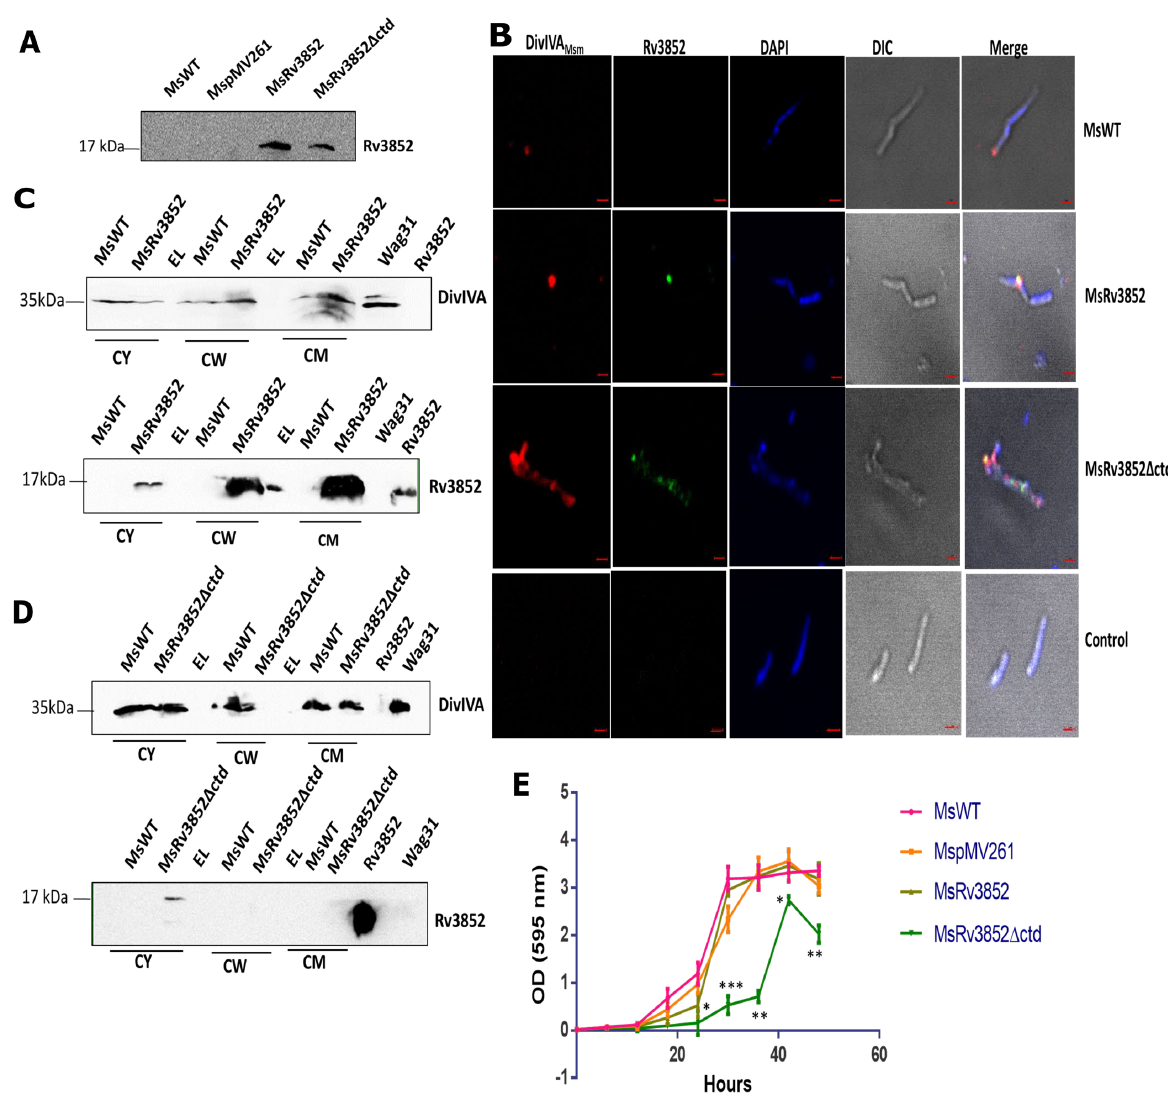
Figure 6. Ectopic expression of Rv3852 in M. smegmatis leads to more DivIVA Msm deposition in cell wall. ( A ) Immunoblot showing the expression levels of Rv3852 and Rv3852∆ctd proteins in M. smegmatis . ( B ) Representative confocal images showing co-localization of Rv3852 (green) and DivIVA Msm (red) in M. smegmatis. Top row: localization of DivIVA Msm . Second row: Co-localization between Rv3852 and DivIVA Msm in MsRv3852. Third row: Co-localization between Rv3852∆ctd and DivIVA Msm in MsRv3852∆ctd. Last row: Cells stained with pre-immune serum. The last vertical lane of each row shows merged image from all four channels. The images were acquired using a Zeiss LSM710 microscope under 100× objective with 2× zoom. Scale bar indicates 1 µm. See Figure S6 for fluorescence intensity distribution pattern for both the proteins in all the three strains. ( C ) Immunoblot showing increased localization of DivIVA Msm in the membrane and the cell wall fractions of MsRv3852 as compared to M. smegmatis . The cytoplasmic (CY), cell wall (CW), and cell membrane (CM) fractions are indicated in (C) and (D). EL stands for empty lane in (C) and (D). ( D ) Immunoblot showing localization of DivIVA Msm in different cellular compartments in MsRv3852∆ctd strain. The densitometry analysis for (C) and (D) is shown in Figure S7. Anti-Wag31 antibody was used for detecting DivIVA Msm . Rv3852 and Wag31 lanes in (C), (D), and (E) show respective pure proteins. ( E ) The growth curve of different M. smegmatis Rv3852 strains. The experiment was performed thrice, and mean OD values were plotted. Error bars show standard deviation. *, **, and *** indicate OD with p values <0.05, <0.01, and <0.001, respectively, in MsRv3852 ∆ctd as compared to MsWT.